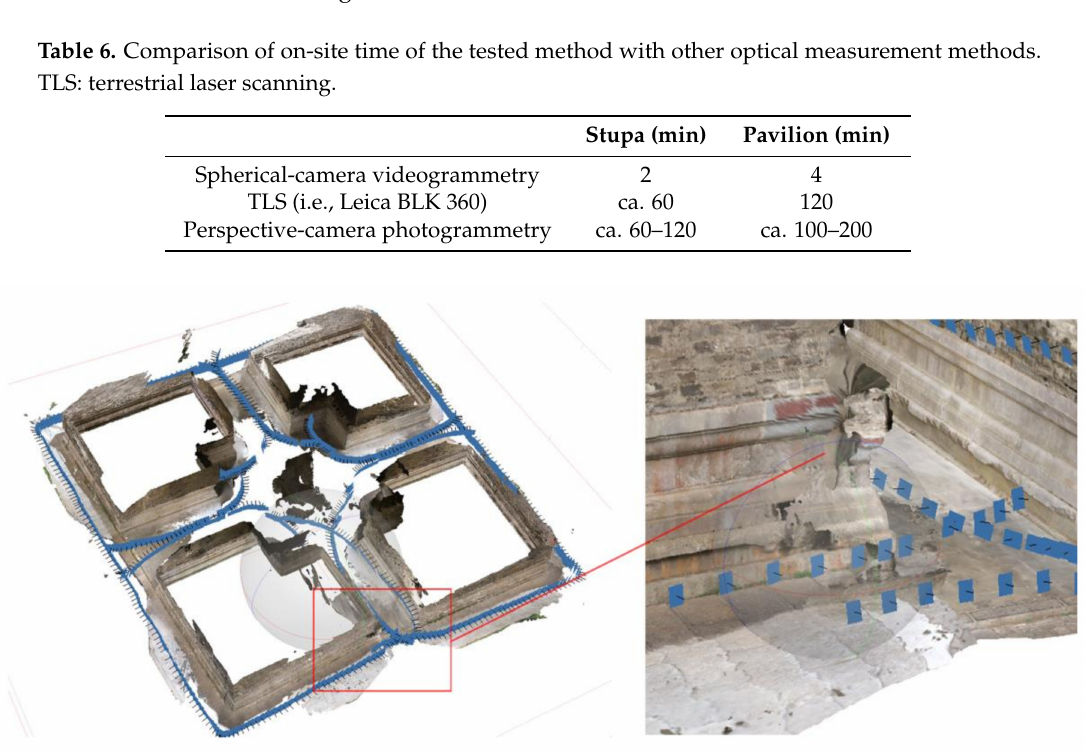
Figure 12. 3D model of the Pavilion dataset obtained with perspective-camera videogrammetry. The model of the pedestals is obviously warped.